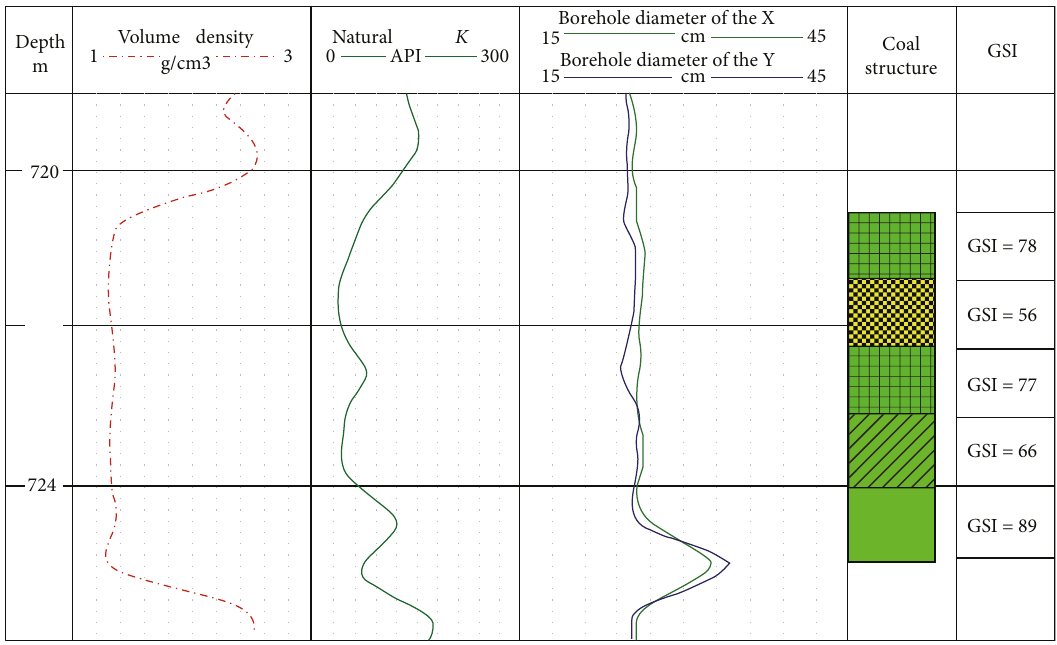
Figure 4: The GSI values for the coal seam section of typical CBM wells.